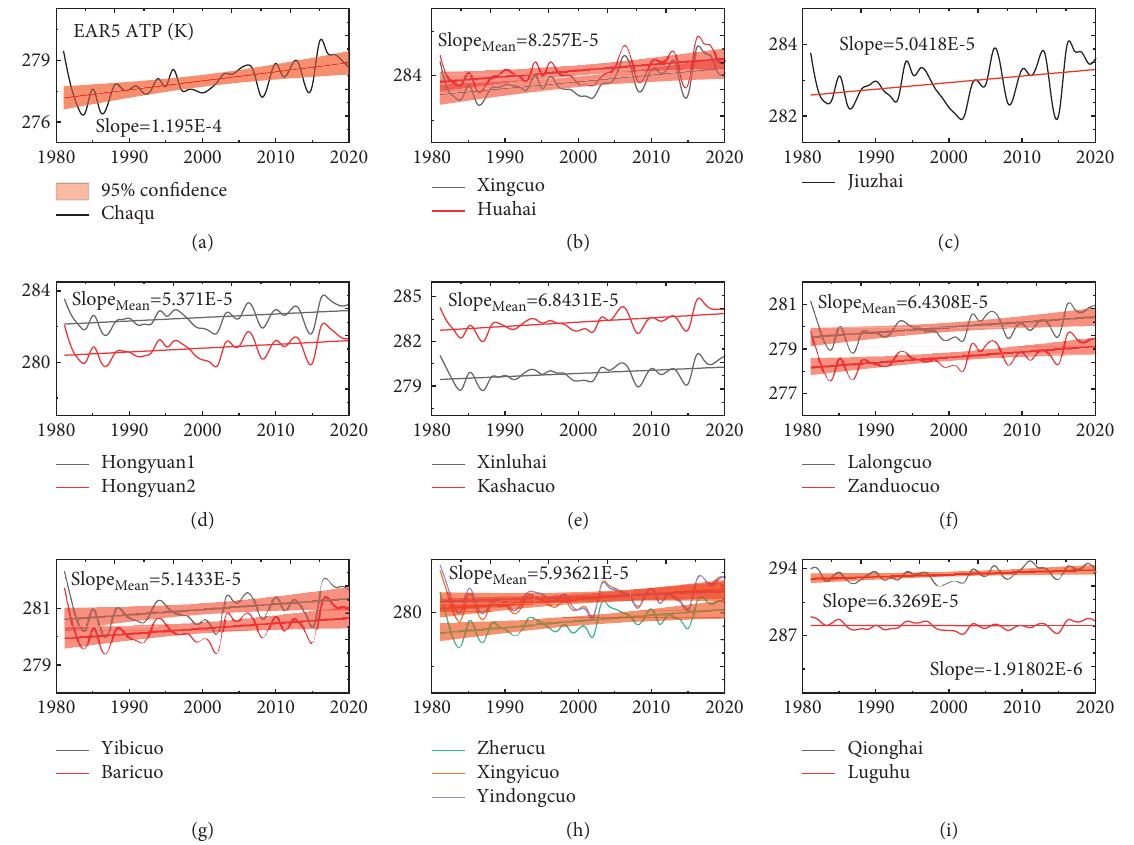
Figure 10: ATP change trend of the lake wetland on a site scale (1980–2020). Latitude of the lake site gradually decreased from subfigure (a) to (i). Elevation of sites (a), (d), (g), (f), and (h) are above 4500m, elevation of sites (b), (c), and (e) are about 3000–3900m, and elevation of site (i) is less than